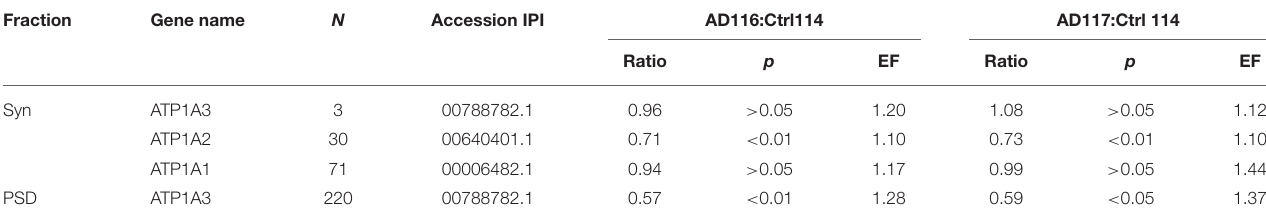
TABLE 2 | Na/K-ATPase in synaptosome and PSD were quantified by iTRAQ analysis. Fraction